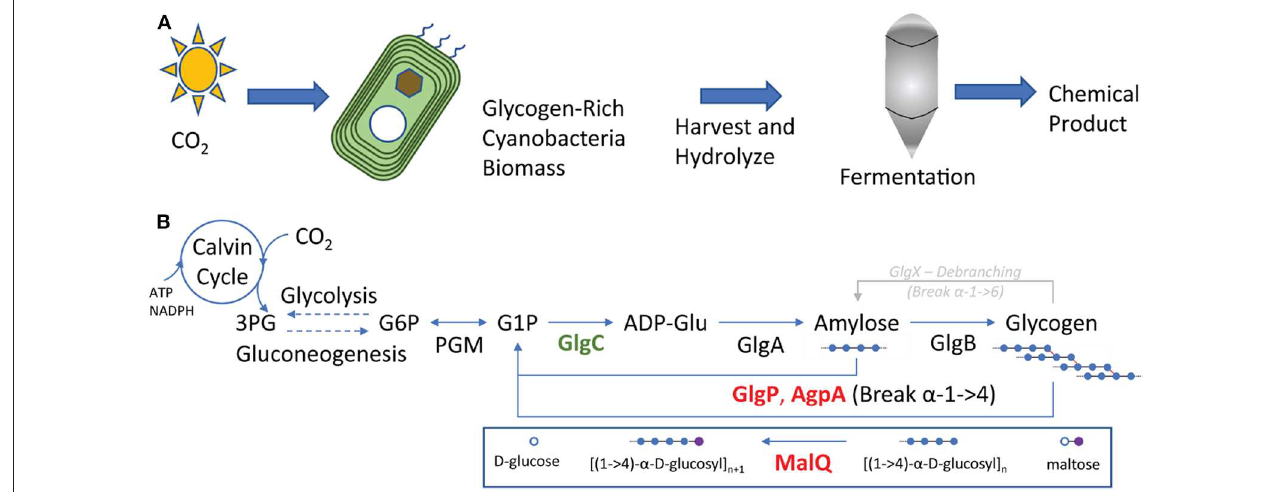
FIGURE 1 | (A) Cultivation of aquatic phototrophs as a feedstock for bioprocessing. Photosynthesis enables the fixation of carbon dioxide into reduced metabolites including energy storage molecules. Cells rich in storage molecules can be harvested, hydrolyzed, and fed to heterotrophs for production of commodity chemicals. The process is analogous to production of terrestrial plant biomass and processing to biofuels and chemicals. (B) Glycogen is produced from the products of the Calvin cycle, producing glucose 1-phosphate though (G1P) gluconeogenesis and phosphoglucomutase (PGM). G1P is converted to glycogen through GlgC and GlgA. Glycogen structure is altered by branching and debranching enzymes, GlgB and GlgX. Finally, glycogen is degraded by linear depolymerases GlgP and AgpA as well as the branched chain pathway including MalQ. Break α -1- > 4 nomenclature refers to breaking the α -1- > 4 glycosidic